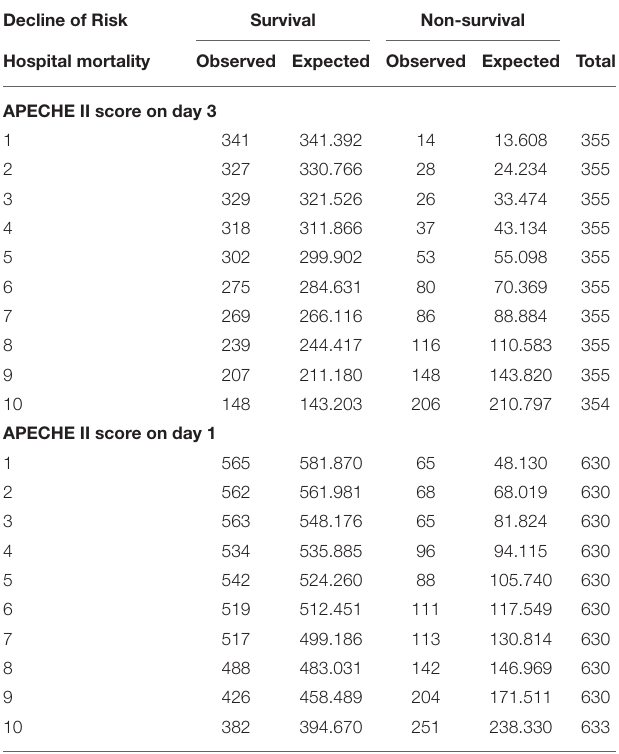
TABLE 3 | The Hosmer-Lemeshow goodness of fit